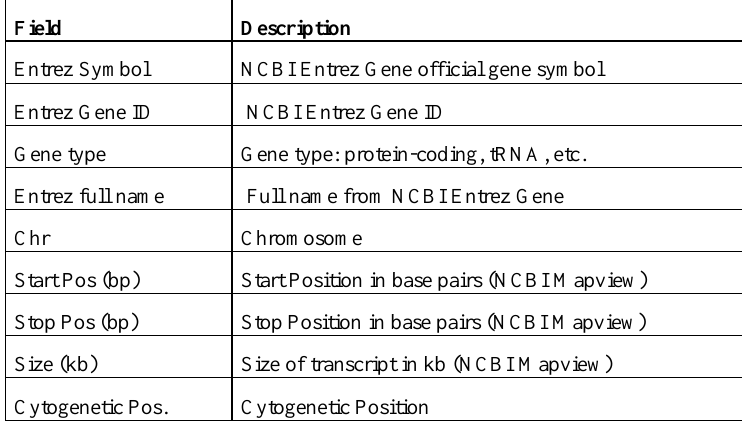
Table 5: Gene based annotation from NCBI Entrez